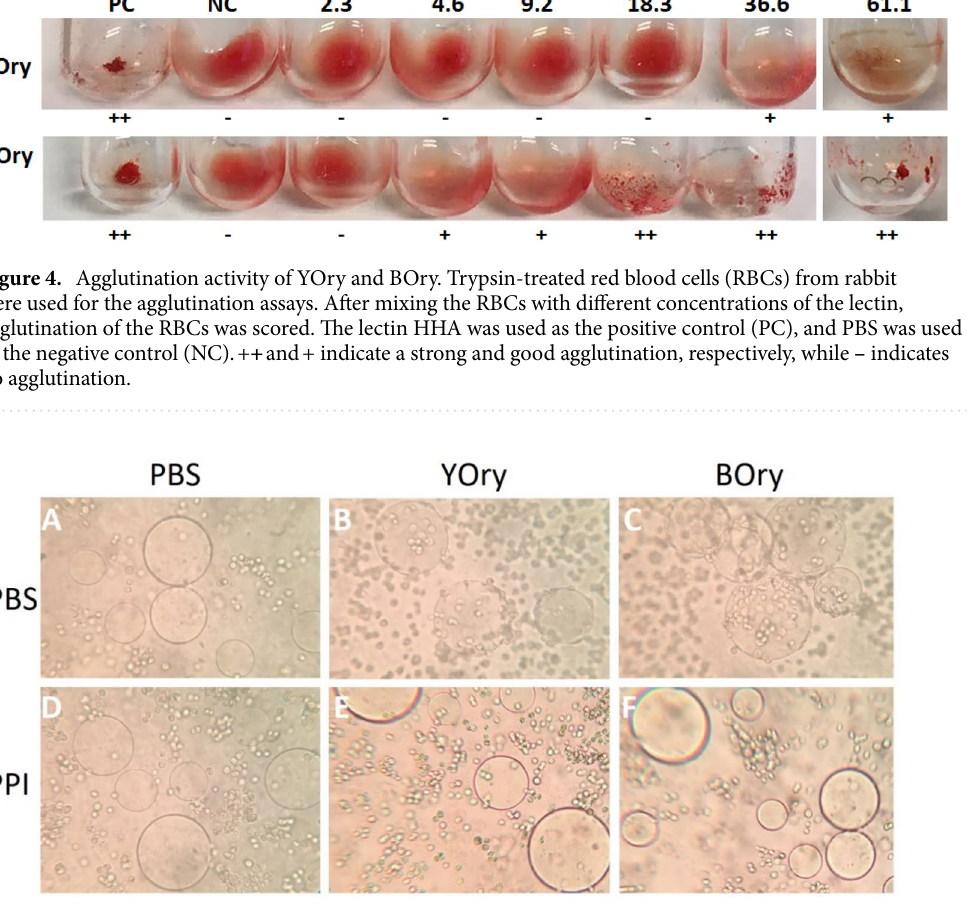
Figure 5. rOrysata-induced cell aggregation depends on phosphatase activity in S2 Drosophila cells. ( A – C ) In each well of the cell-repellent 96-wells plate, rOrysata-coated Ni–NTA agarose beads or PBS-treated blank beads were incubated with S2 cells for 40 min. ( D – F ) before adding the lectin-beads, cells were treated by 0.2× phosphatase inhibitors for 10 min. The formation of cell aggregation was recorded by cell phone camera attached to light